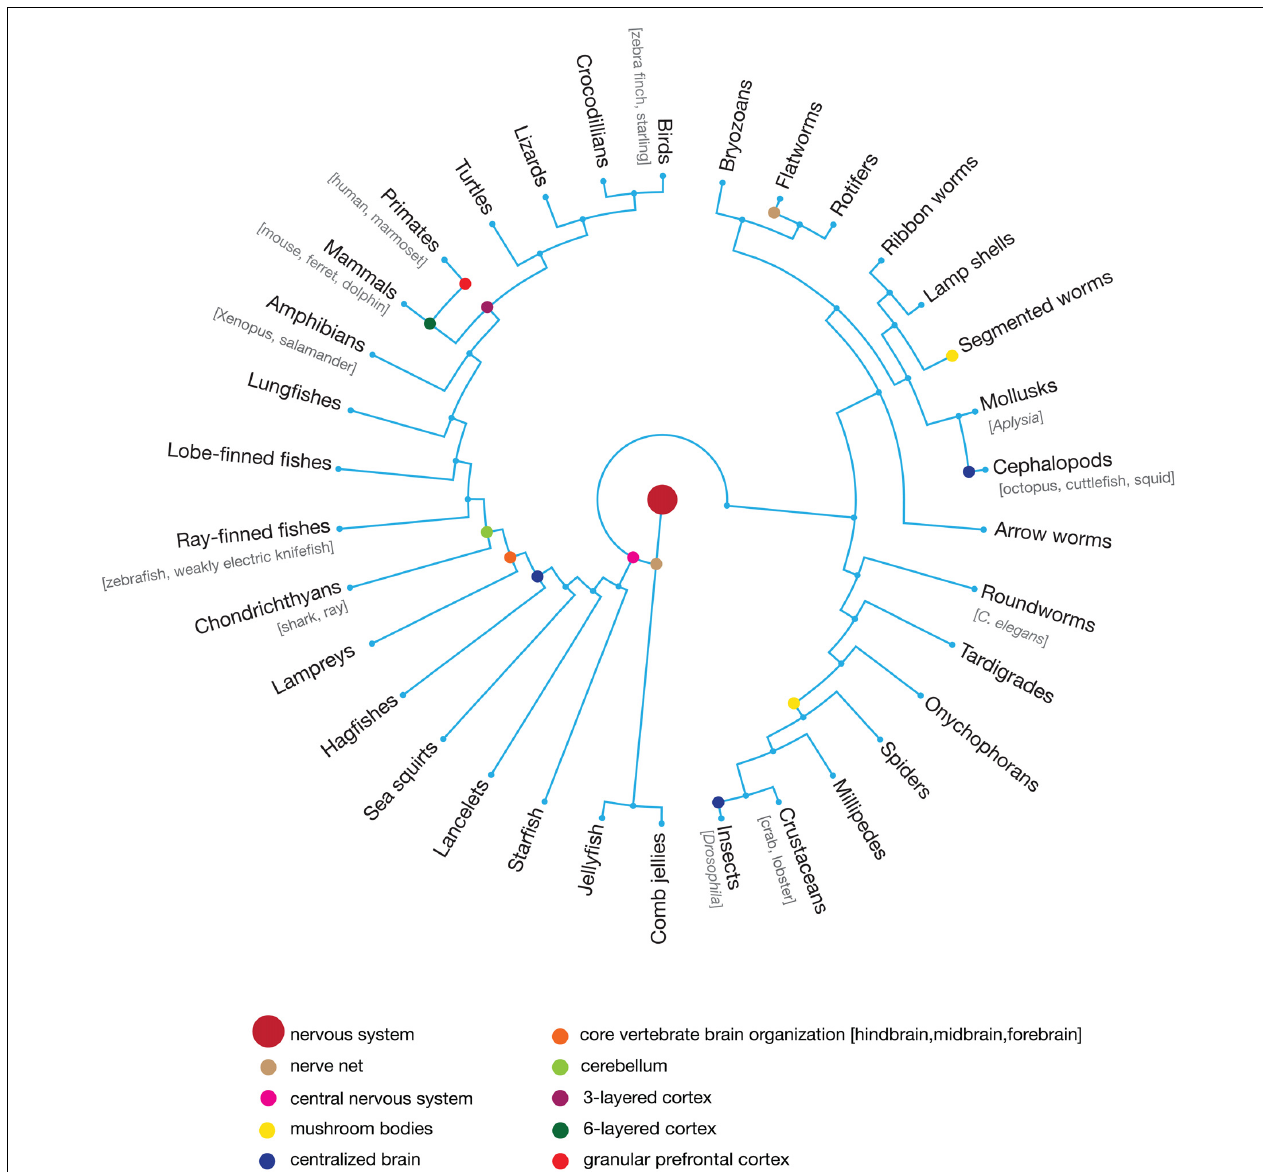
FIGURE 1 | Circular evolutionary tree of representative animal taxa that emerged following the evolution of the nervous and vestibular systems. While junctions of branches represent the degree of phylogenetic relatedness over evolution, distance along the tree does no scale with actual time in natural history. Colored circles indicate last common ancestor for phylogenetic groups that exhibited a particular characteristic of the nervous system which can be used to reconstruct shared, unique and convergent features of nervous systems. The central nervous system emerged early in animal evolution and is homologous across multiple taxa, while granular prefrontal cortex is a unique property of primate brains. Likewise, the independent evolution of centralized brains in vertebrates and multiple invertebrate taxa—insects and cephalopods—represents an example of convergent evolution. The more commonly used “model” organisms in neuroscience are listed in brackets below their taxonomic groups, though this list is not